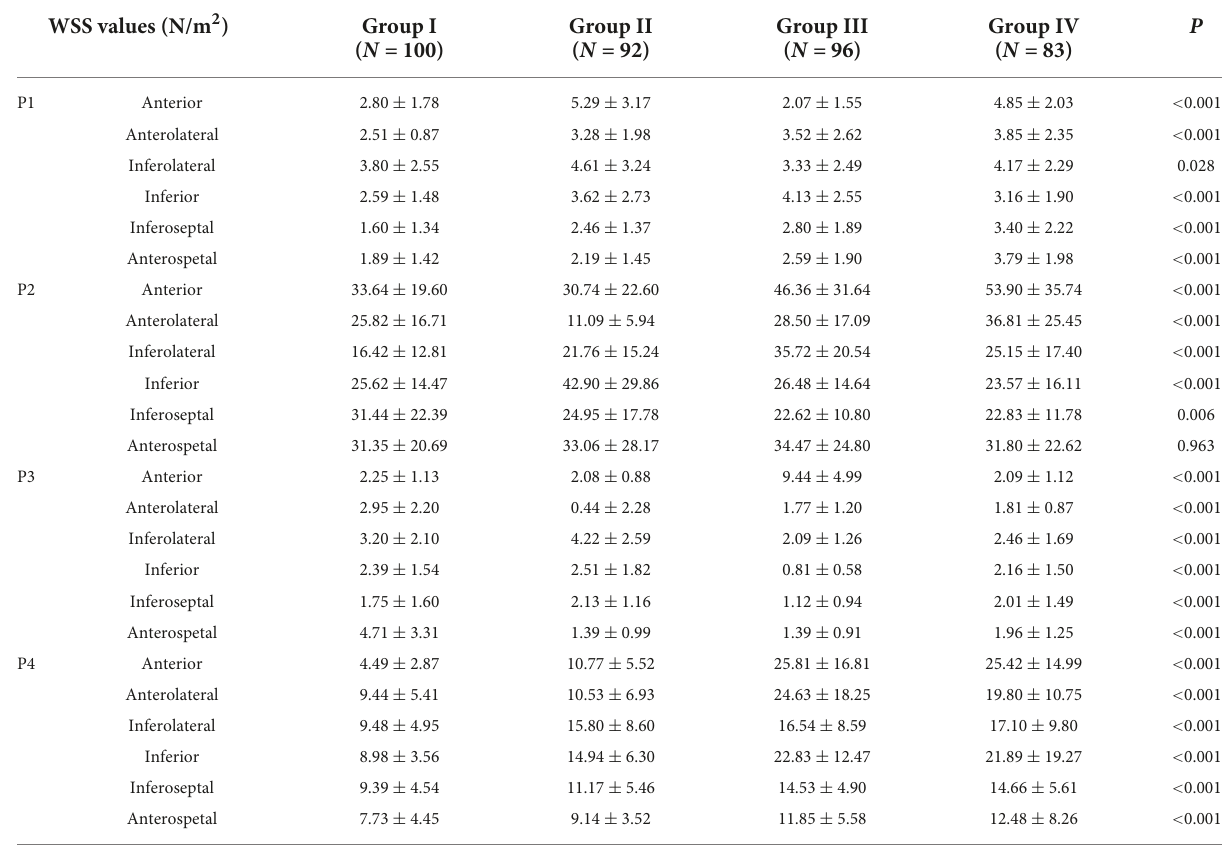
TABLE 2 The LV WSS values in the diastolic period stratified by different age groups. WSS values (N/m 2 )